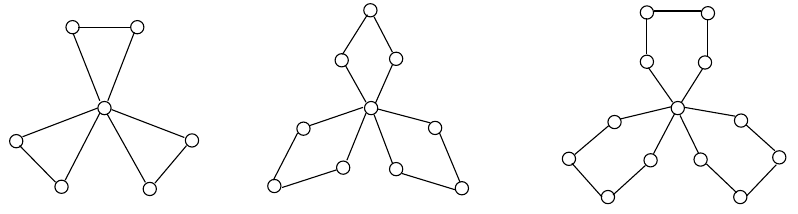
Figure 5: The Dutch windmill graphs D 3